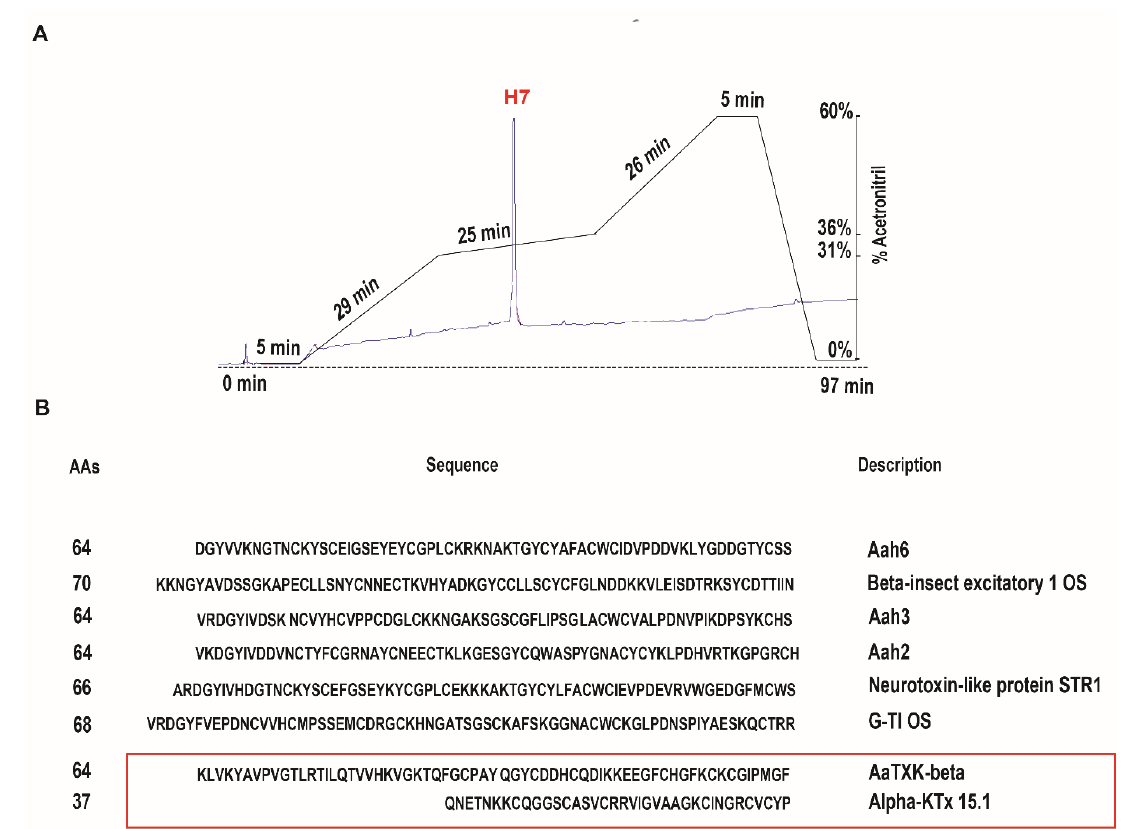
Figure 5. NanoLC/HRMS-MS analysis of H7. ( A ) Purification of H7 subfraction. The purification of fraction H7 was repeated on a C18 column with a modified gradient allowing to collect a unique sharp peak eluted at 38 min. ( B ) H7 fraction was subjected to disulfide bridges reduction and trypsin digestion, and the obtained peptide mixture was analysed by NanoLC/HRMS-MS. Data analysis led to the identification in the H7 fraction of Aah6, Beta-insect excitatory 1 OS, Aah2, Aah3, Neurotoxin-like protein STR 1, G-TIOS, alpha-KTx 15.1 and AaTXK-beta. Signal peptide and polypeptide sequences are not reported. Table 2. Classification of the peptides contained in H7 according to their activities.